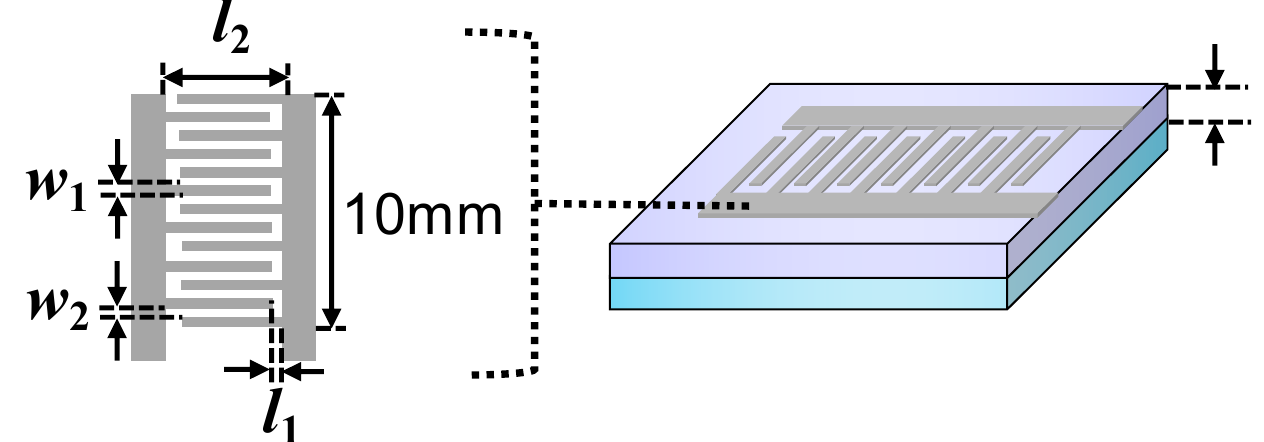
Figure 6. Dimensions of the aluminum electrode. l 1 = 0.6 mm, l 2 = 4.8 mm, w 1 = 0.4 mm, w 2 = 0.4 mm, and n = 13 interdigitated electrode